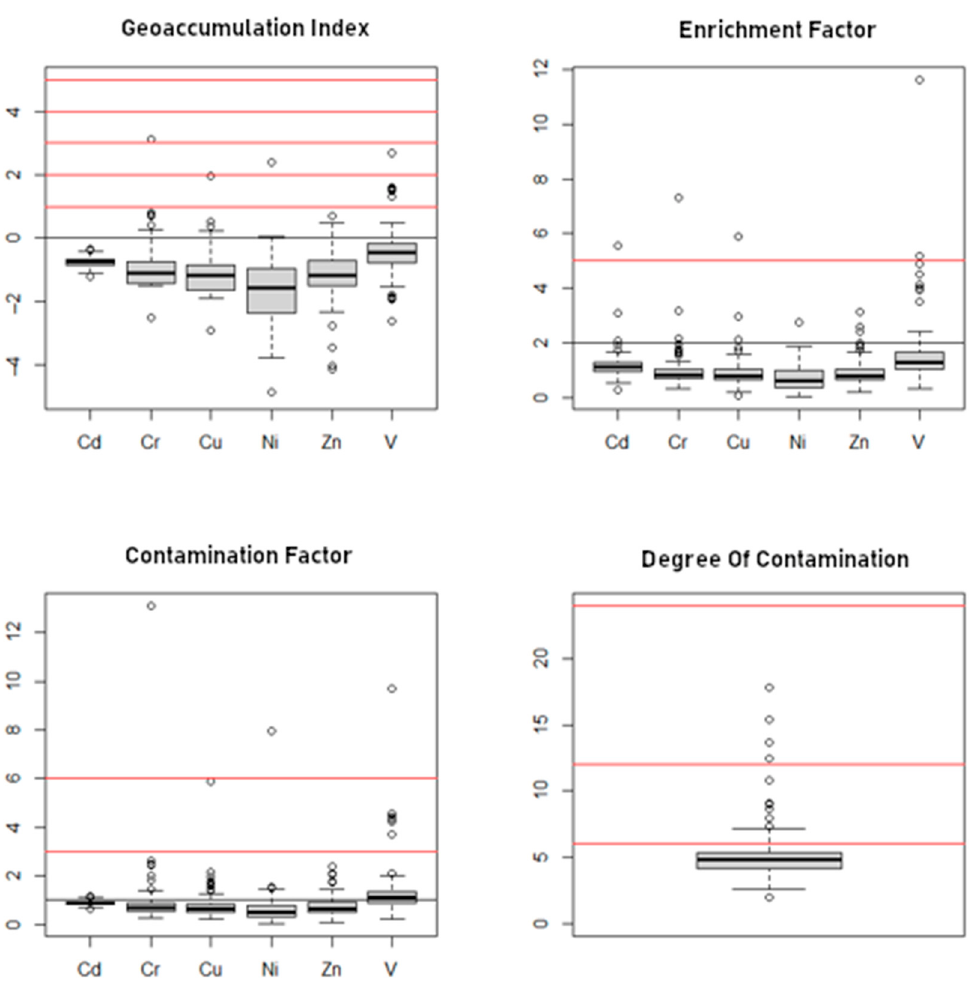
Figure 5. Graphs of ecological indicators.